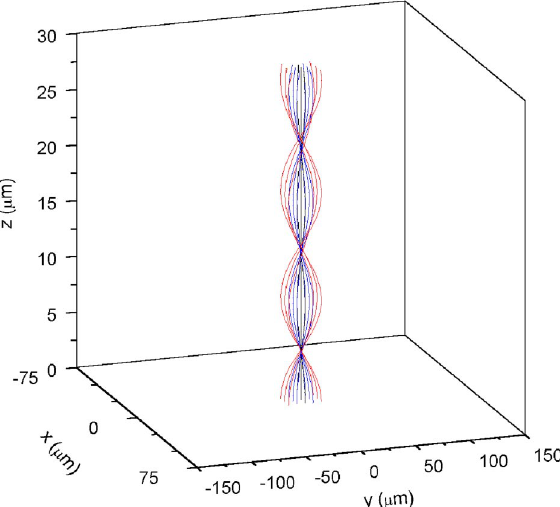
FIG. 18. (Color) 3D orbits for 15 sampled accelerated particles initially distributed within a rectangle of j x j (cid:12) 5 (cid:4) m and j y j (cid:12) 15 (cid:4) m , with grid points of x (cid:3) (cid:6) 5 , 0, 5 (cid:4) m and y (cid:3) (cid:6) 15 , (cid:6) 7 : 5 , 0, 7.5, and 15 (cid:4) m ; six orbits initially at y (cid:3) (cid:4) 15 (cid:4) m are marked with red, six orbits at y (cid:3) (cid:4) 7 : 5 (cid:4) m are marked with blue, and three orbits at y (cid:3) 0 are marked with black. Since (cid:5) x; 0 ; z (cid:7) (cid:3) 0 from Fig. 17(b), the three black orbits lie on the F y (cid:5) 0 ; y; z (cid:7) (cid:3) 0 from Fig. 17(a), and thus x - z plane. Similarly, F x there are five orbits that lie on the y - z